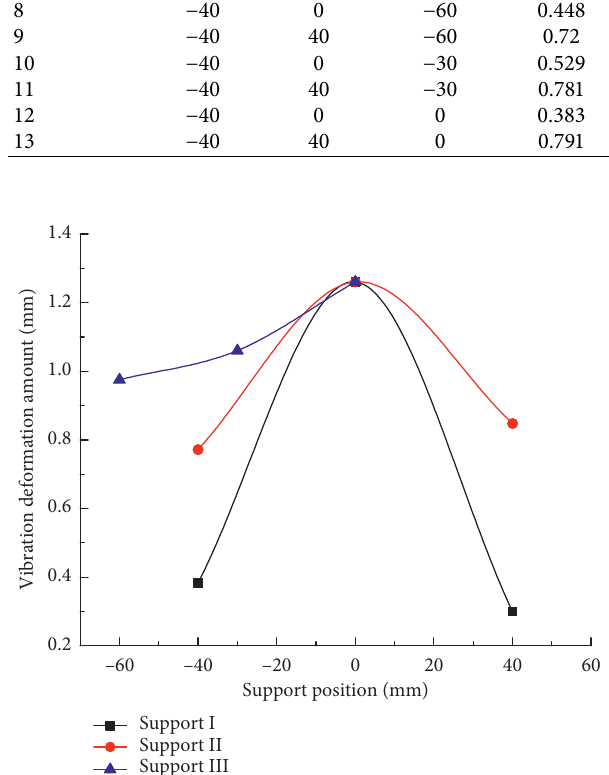
Figure 10: Influence of the supports’ positions on vibration de- formation, measured